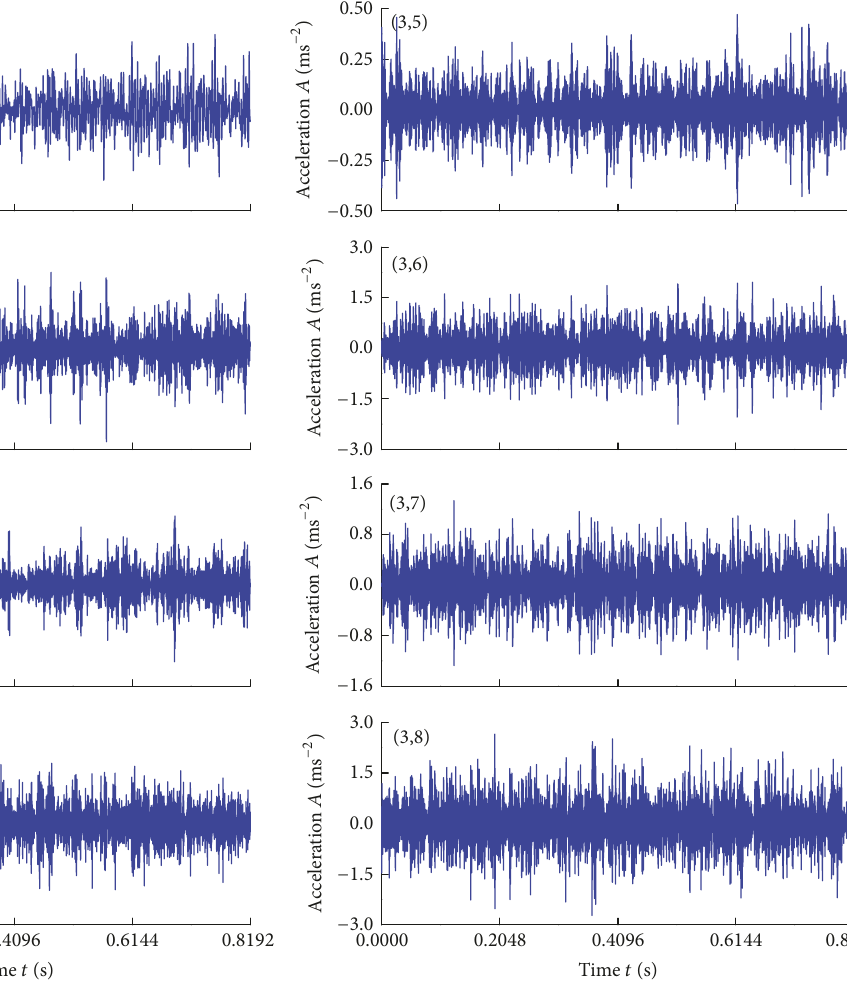
Figure 5: Multiscale signals obtained by WPT.